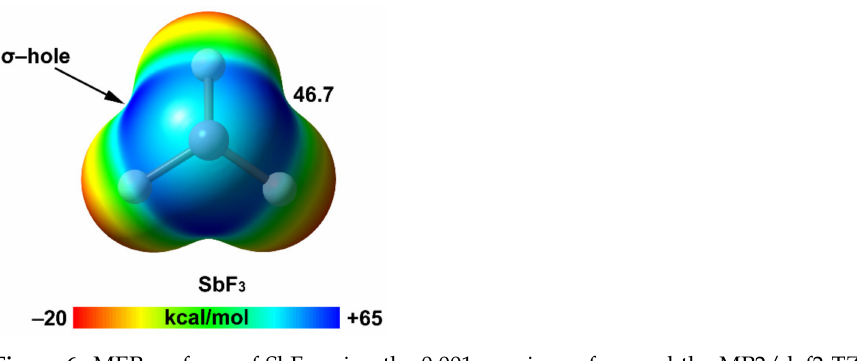
Figure 6. MEP surfaces of SbF 3 using the 0.001 a.u. isosurface and the MP2/def2-TZVP level of theory (energy in